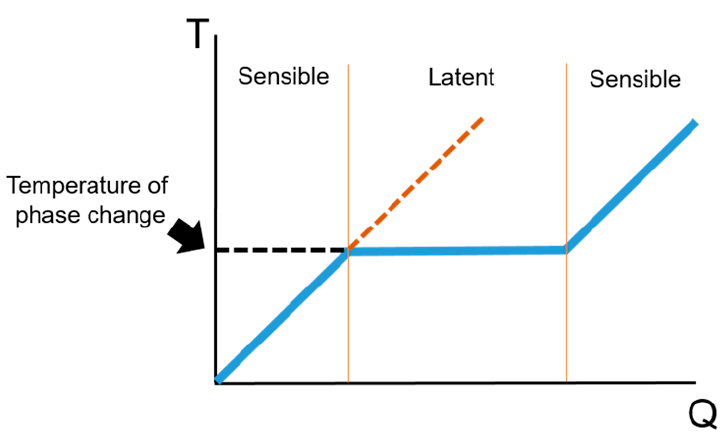
Figure 11. Phase change profile of PCM (adapted from Gil et al. [31]).